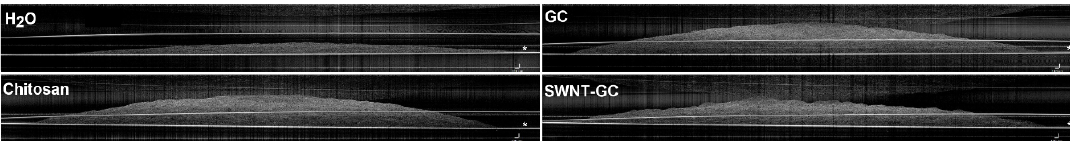
Figure 2. Optical coherence tomography (OCT) imaging comparing morphological differences between aFPCM with and without chitosan derivatives. Matrices were photographed on day 6. Photographed images provided cross-sectional contours of aFPCM at maximum tension generated across each treatment group on day 6. All images were captured before anchorage release for contraction or differentiation assays. The plate line representing the bottom of the aFPCM is beneath the asterisk on the right of each image. Images shown are from one experiment but representative of all reported cell types and experiments.